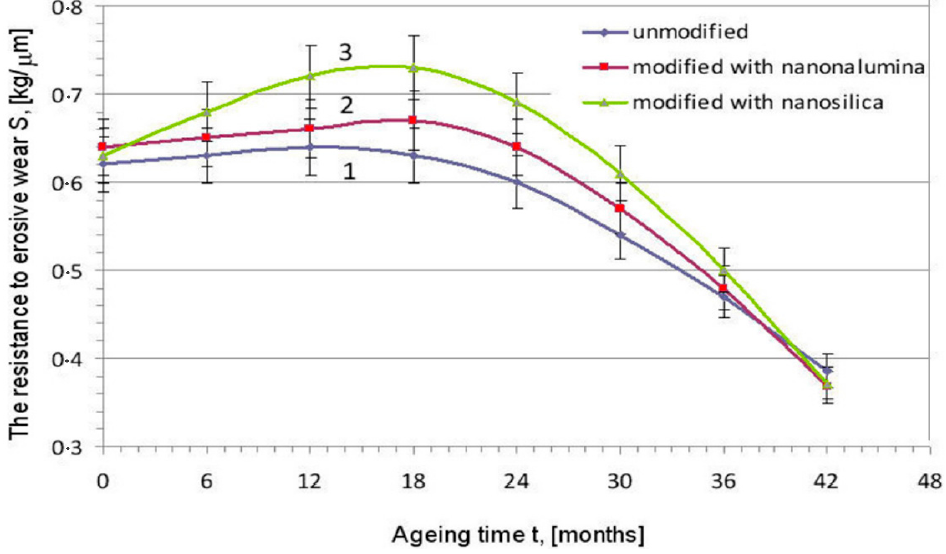
Figure 5. Representation of resistance to erosive wear of various coatings against aging time [46].